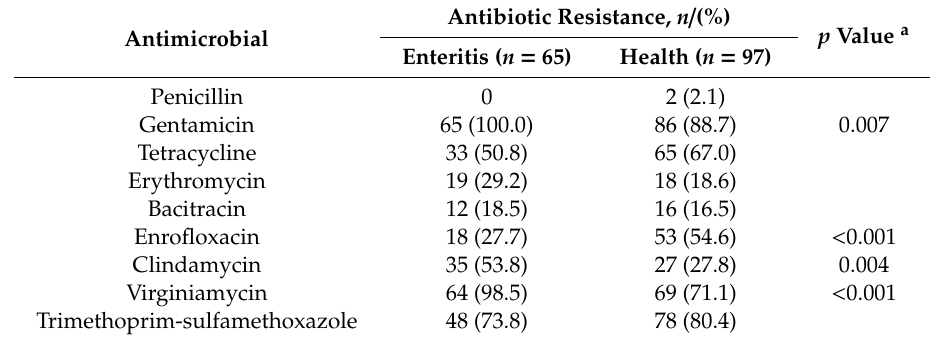
Table 2. Antimicrobial resistance of Clostridium perfringens isolates from chickens with or without necrotic